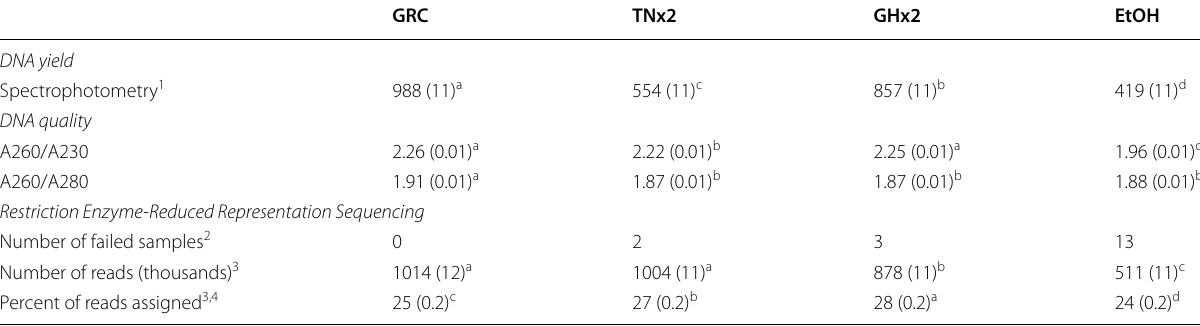
Table 3 Average DNA yield and quality of sheep rumen samples using four sample preservation methods